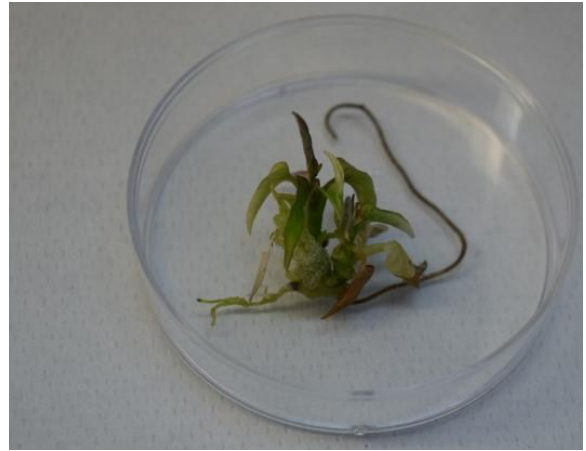
Figure 6. Shoots of Ipomoea batatas L. after 12 months of in vitro slow-growing (Photo credit: Claudia Ruta - from https://biodiversitapuglia.it).